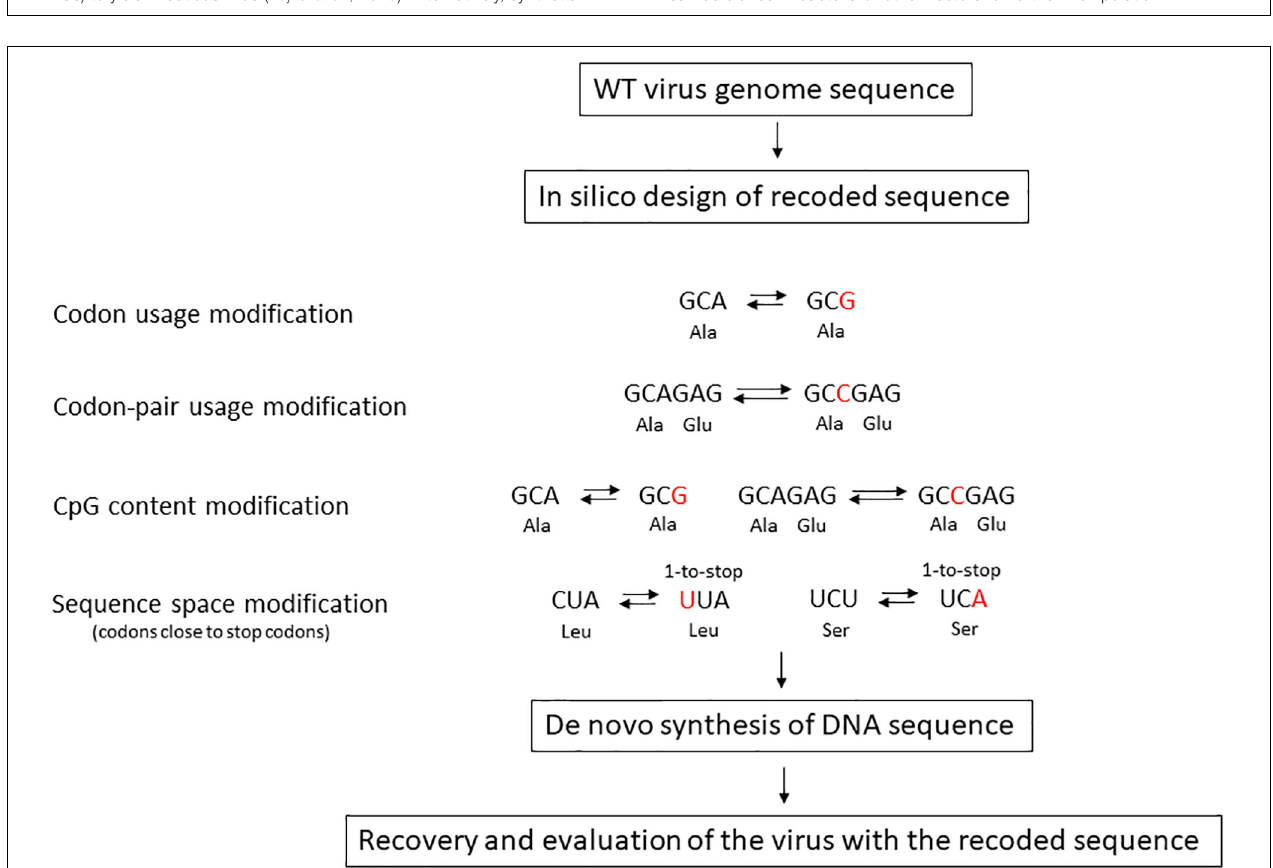
FIGURE 2 | Methods for genome synonymous recoding. Four main strategies have been used to synonymously recode virus genome sequences: codon usage modification, codon-pair usage modification, CpG content modification, and modification of codons that can generate stop mutations after a single nucleotide